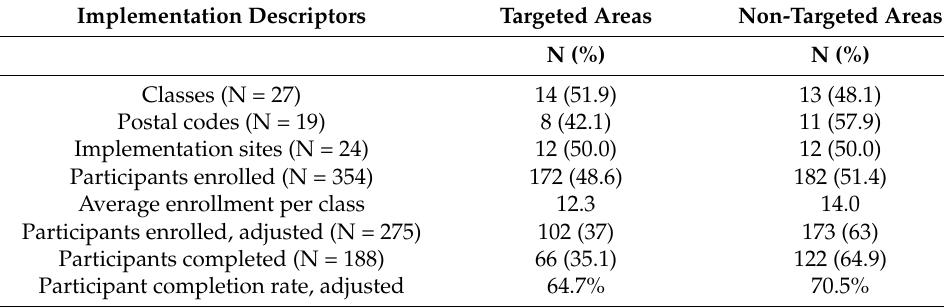
Table 2. Descriptive data of AMOB implementation, July 2019 to June 2020.